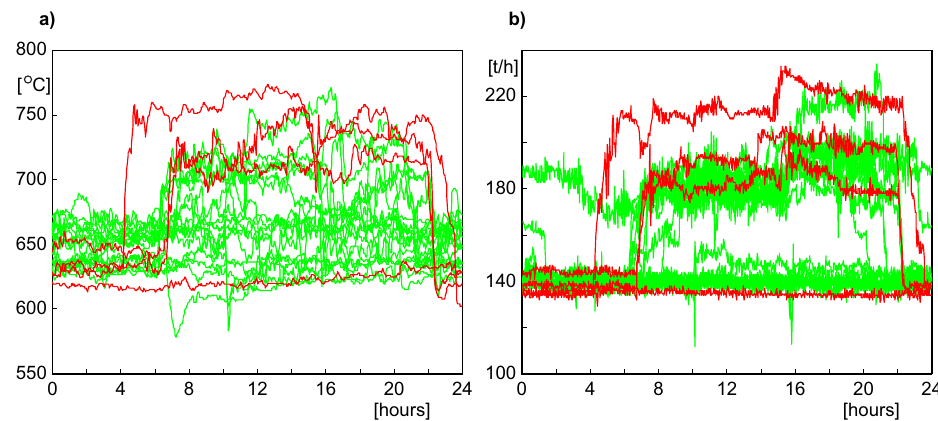
Figure 8. Variability of two process variables in the period from 22nd December 2013 to 13th January 2014, after split into one-day batches: ( a ) Temperature of fumes in the left channel. ( b ) Flow of water feeding the